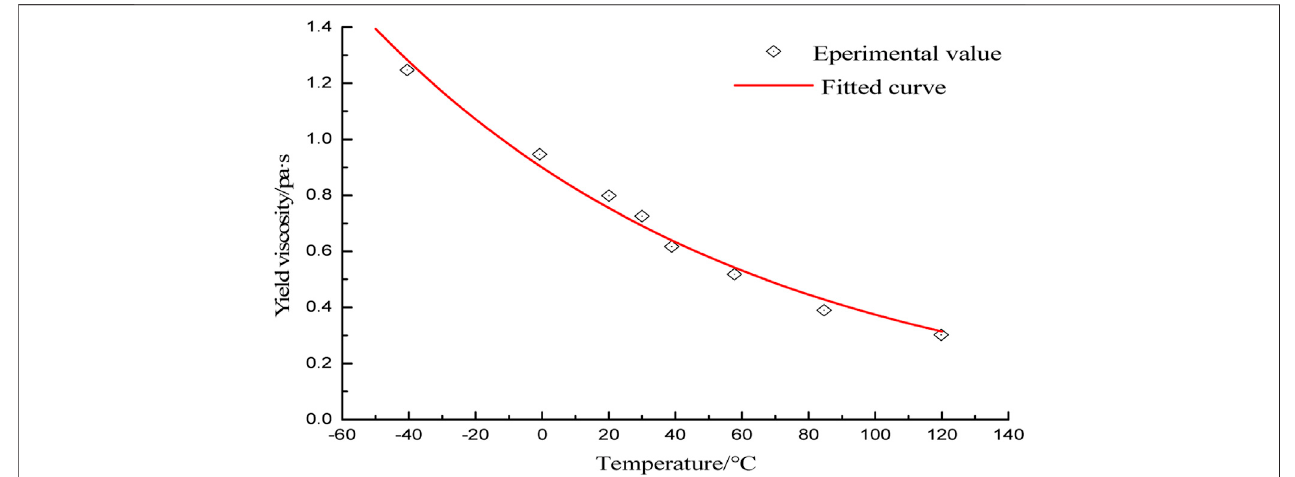
FIGURE 5 | Characteristic curve of MR fl uid ( η ∼ T